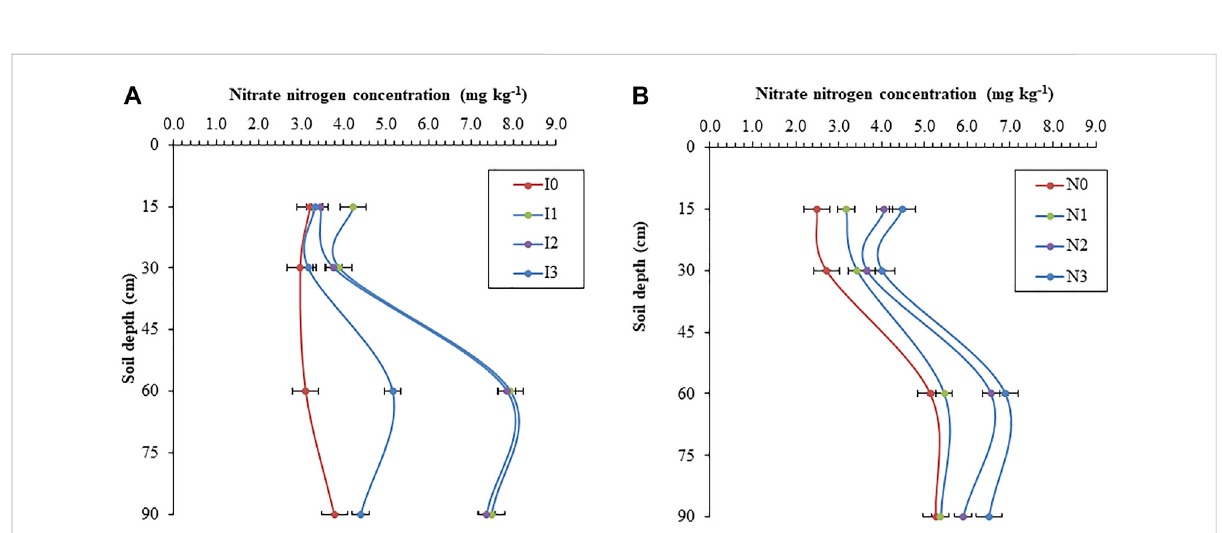
FIGURE 9 (A,B) Effect of different irrigation regimes and nitrogen levels on the nitrate-nitrogen concentration in the soil pro fi le (0 – 90 cm) after the harvest of wheat crops (mean ± standard